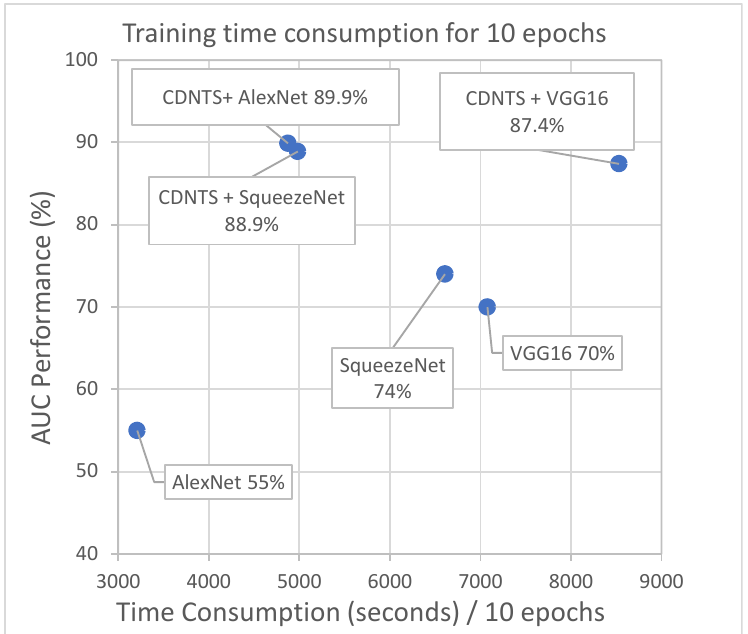
Figure 10. Time cost comparison of experiments 1 and 2. Alexnet 55%, squeezenet 74%, and VGG16 70% are time cost of experiment 1. CDNTS + Alexnet 89.9%, CDNTS + squeezenet 88.9%, and CDNTS + VGG16 87.4% are time cost of experiment